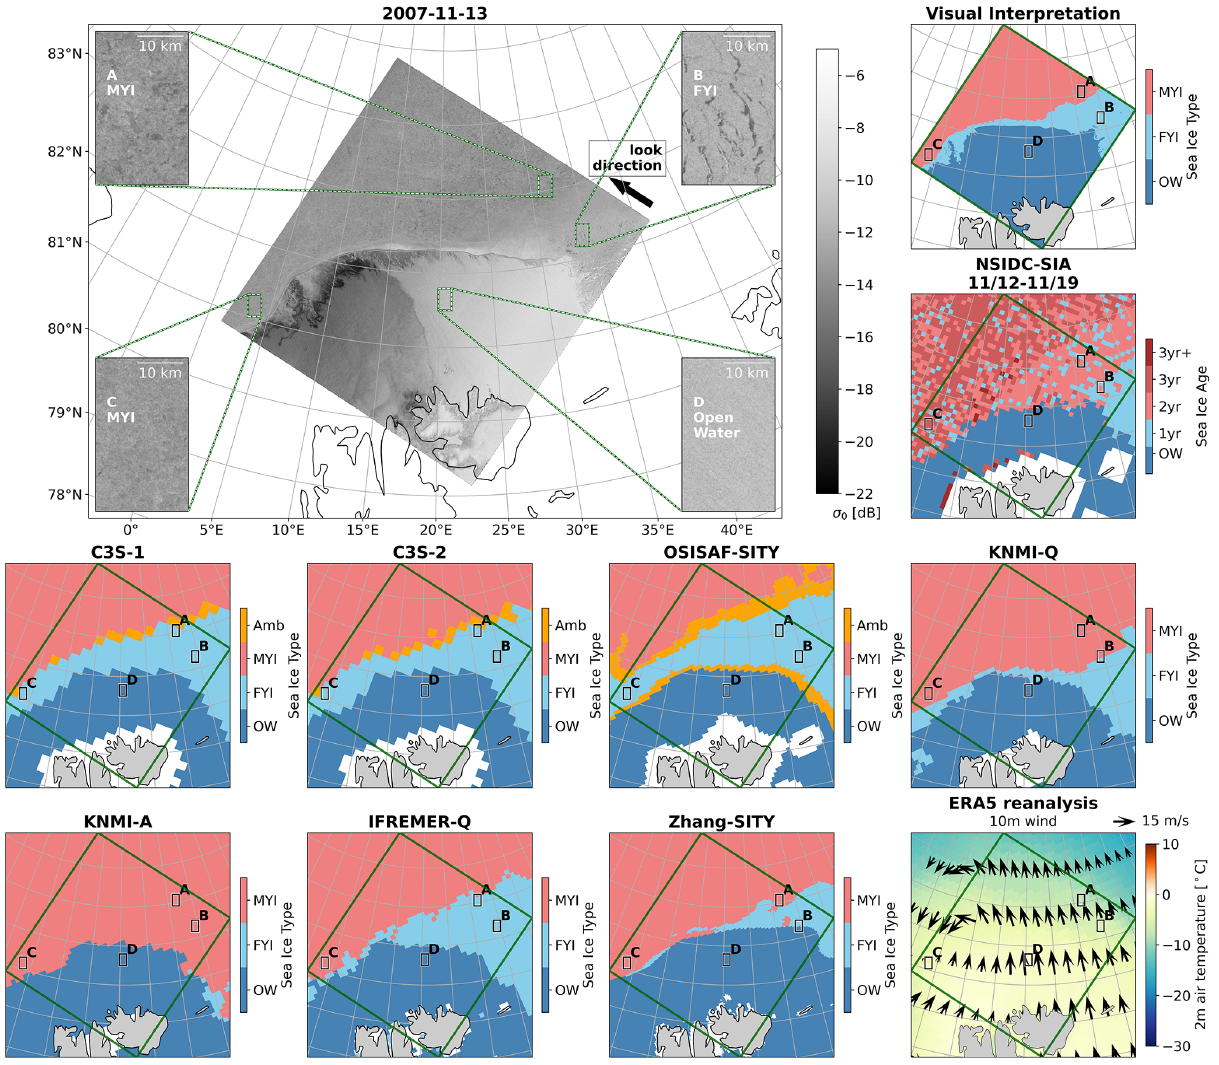
Figure 9. RS-1 image, ice type distribution from seven SITY products (C3S-1, C3S-2, OSISAF-SITY, KNMI-Q, KNMI-A, IFREMER-Q and Zhang-SITY), weekly NSIDC-SIA product and visual interpretation result based on the SAR image, along with 2m air temperature and 10m wind from ERA5 reanalysis on 13 November